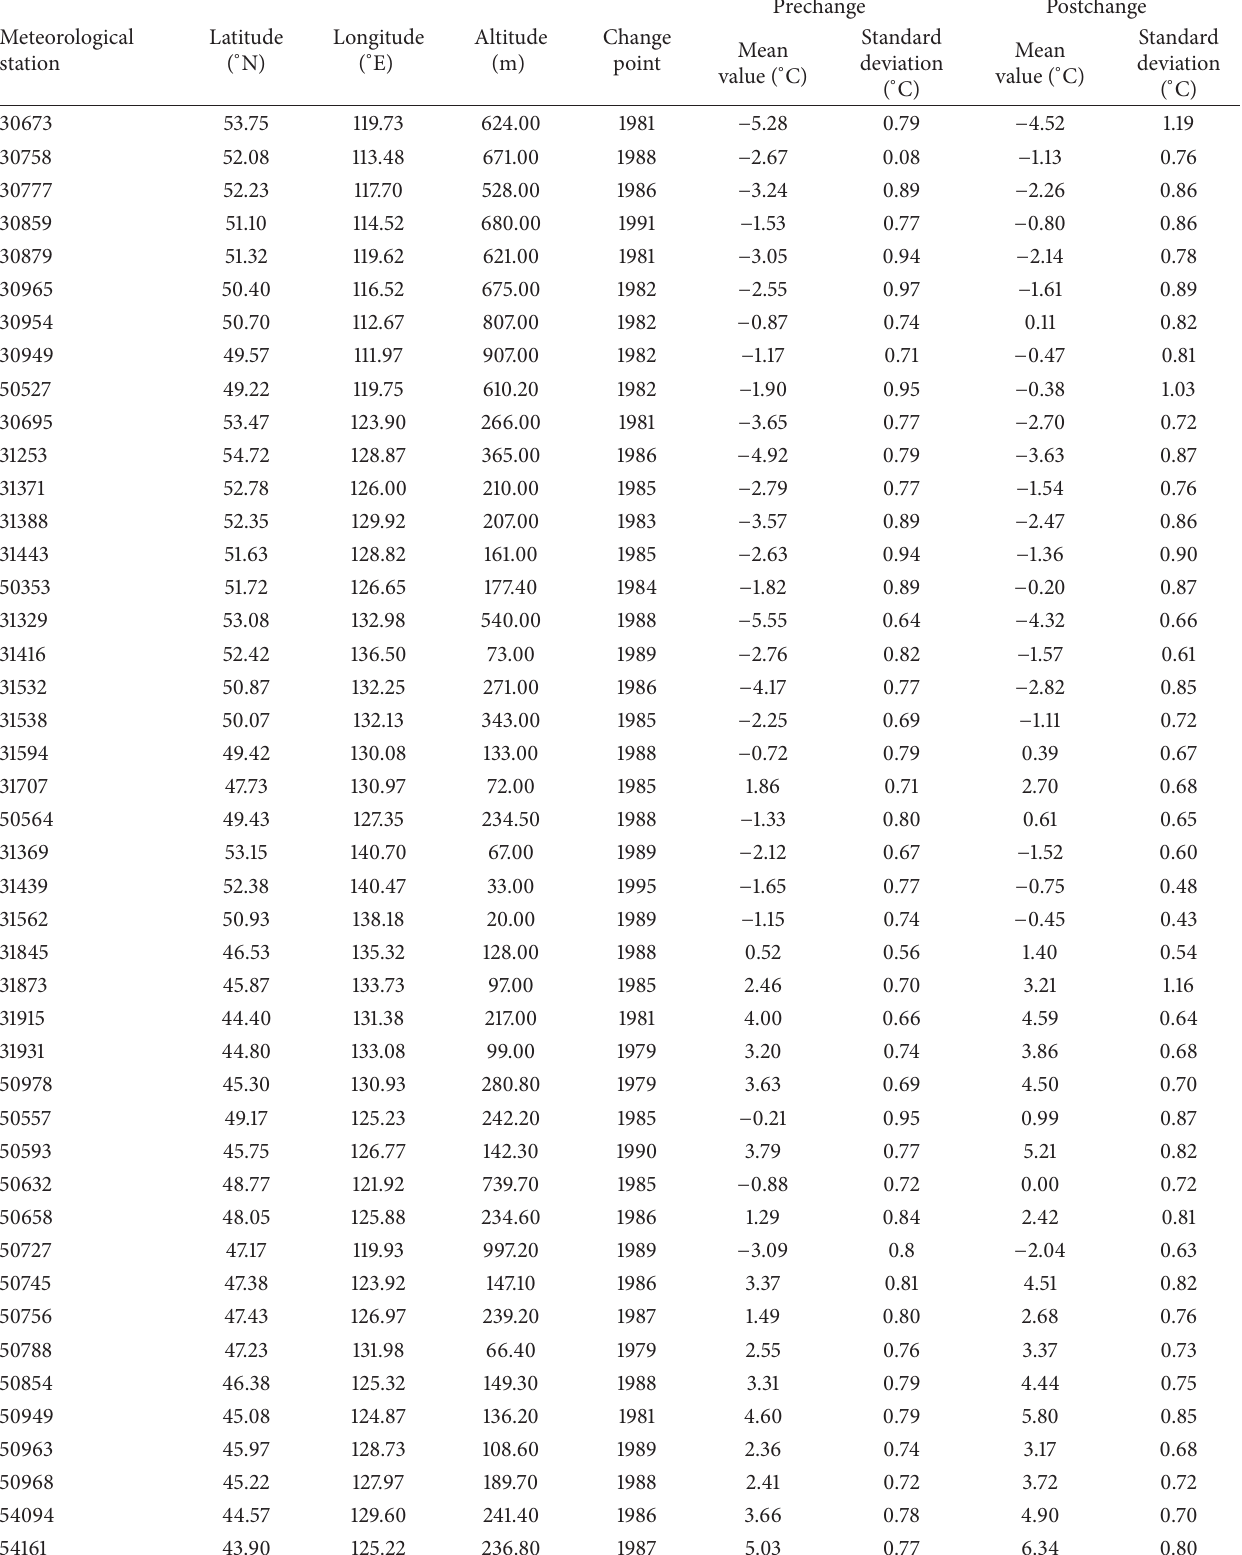
Table 1: Climate change detection and descriptive statistics of the annual mean temperature